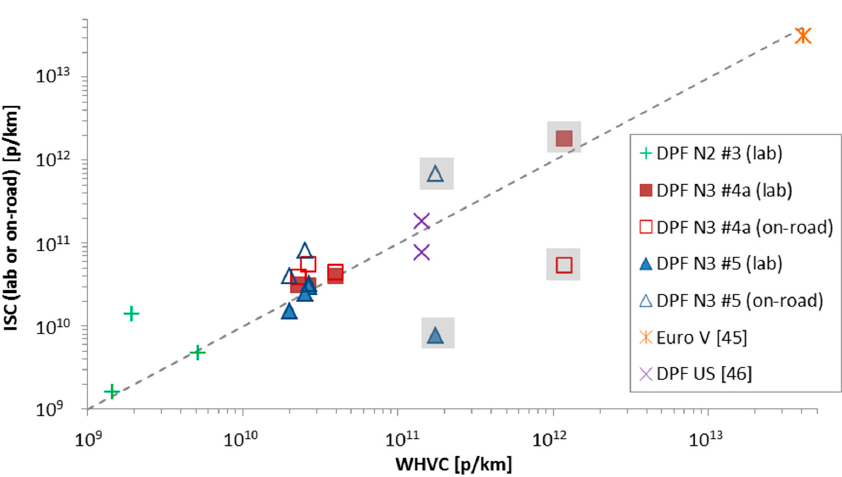
Figure 7. Correlation of different phases of WHVC and ISC cycles (cold start, urban, rural, motorway) in the laboratory and on the road. Symbols with grey background refer to urban cold start emissions.